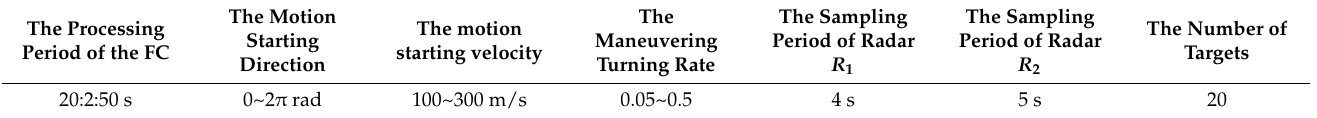
Table 7. The parameter settings for simulation scenario